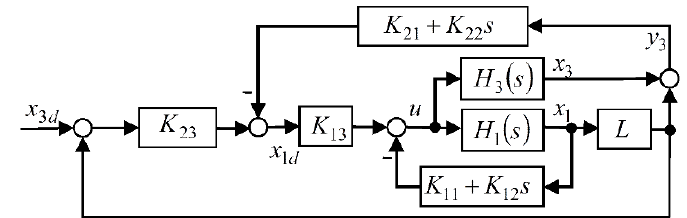
Figure A1. Cascade MPC controller for CIP system